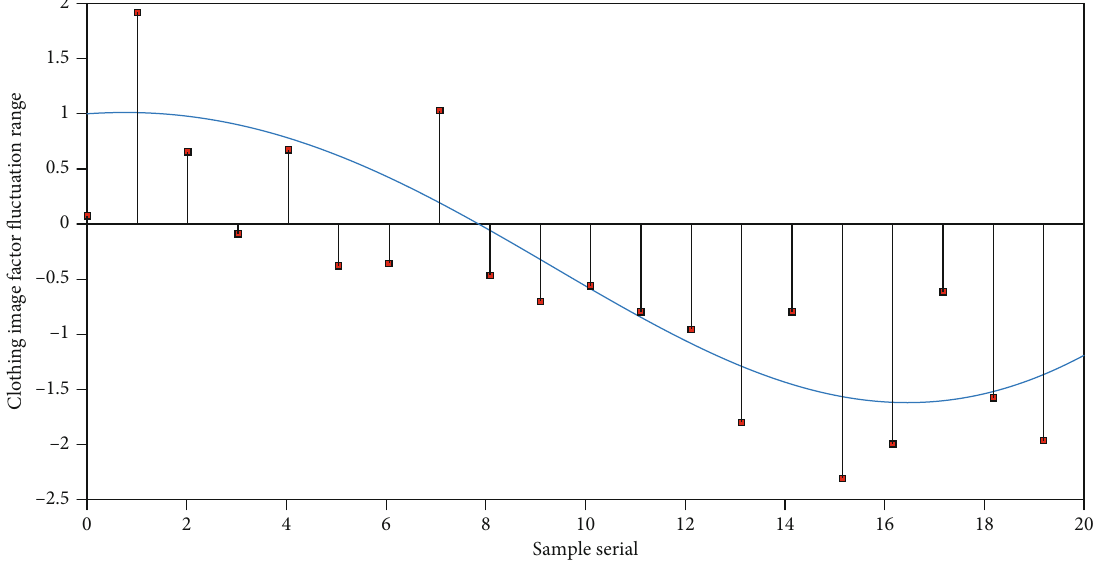
Figure 7: The distribution of the fl uctuation range of clothing image factors.